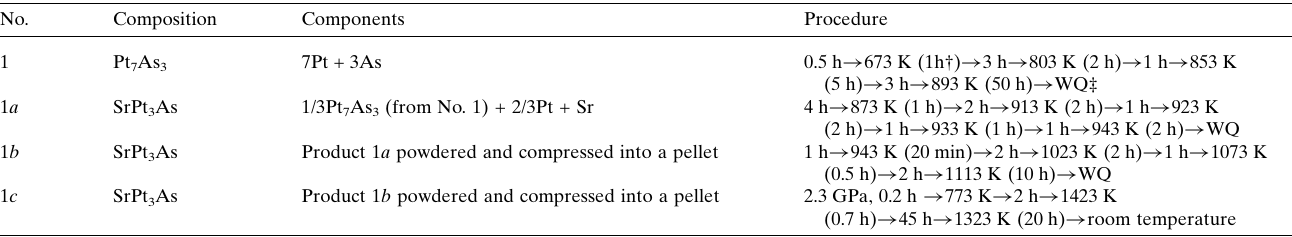
Table 1 Details of the high-pressure synthesis of Sr 2 Pt 8 (cid:2) x As single crystals. No. Composition Components